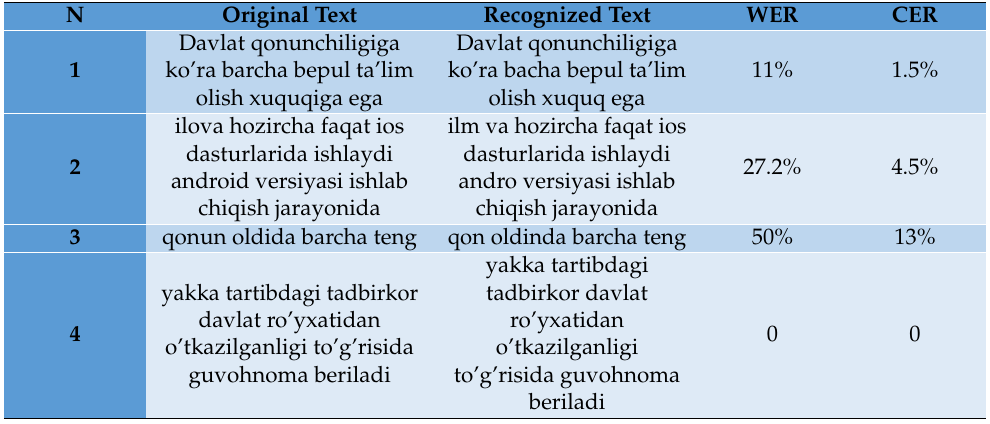
Table 7. Examples of the application of the created language model to the speech recognition system.